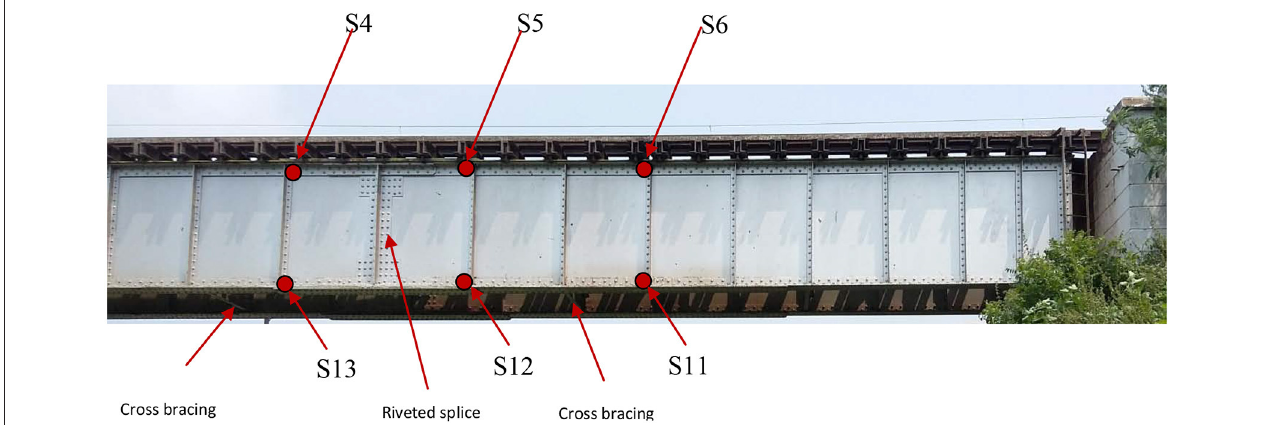
FIGURE 5 | Ponneri bridge—connection